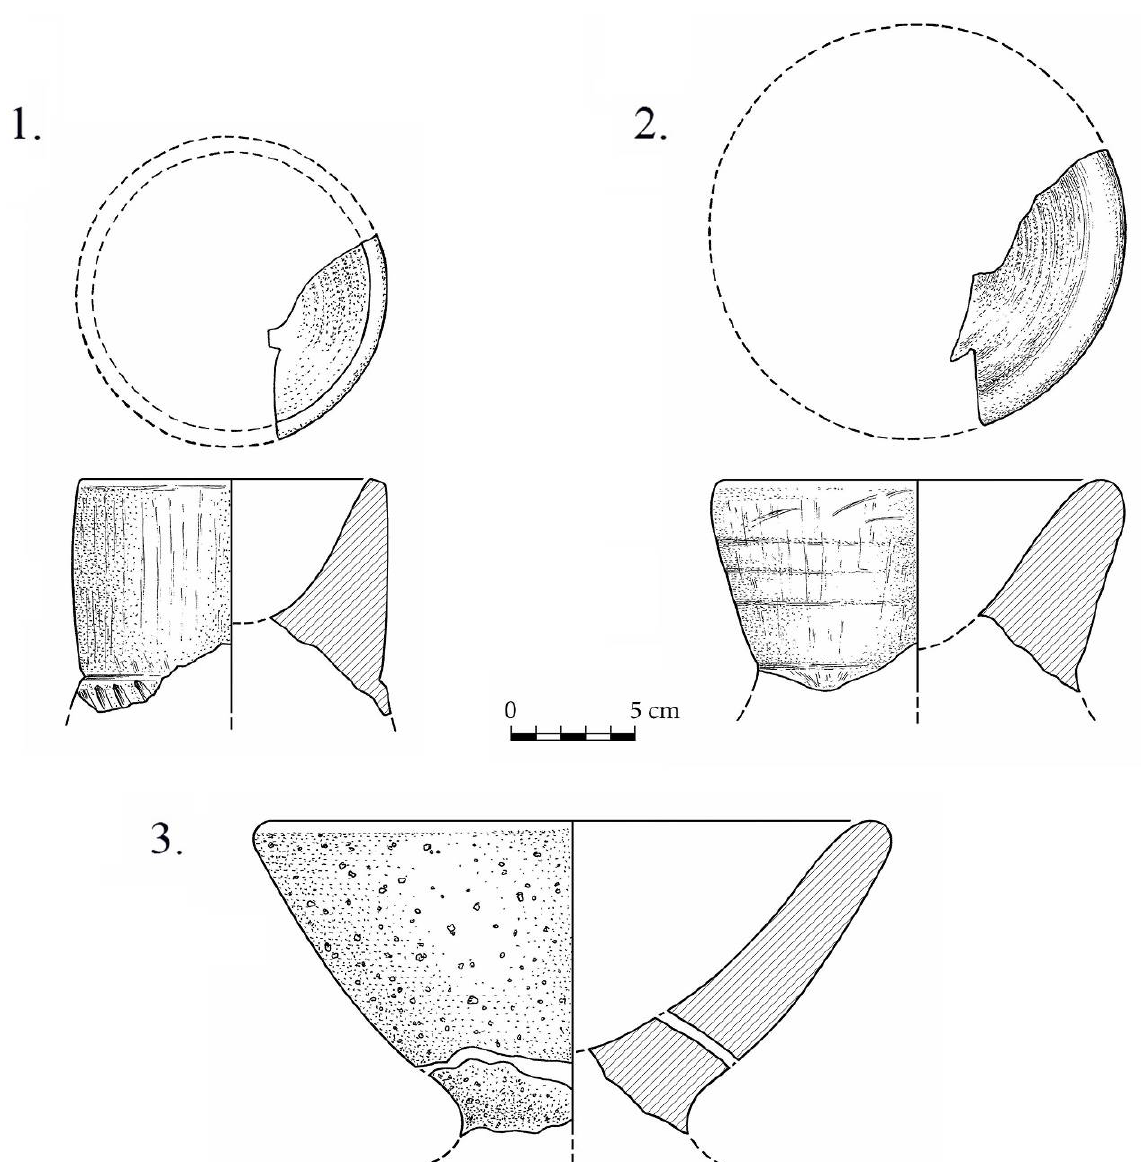
Figure 5. Unclassified fragments. 1. Basket C373/1, locus - C174, raw material - limestone, notes - rim, rope decoration, chisel marks. 2. Basket C120/1, locus - C58, raw material - limestone, notes - rim, chisel marks. 3. Basket C1248/1+2, locus - C597, raw material - basalt, notes - rim and neck